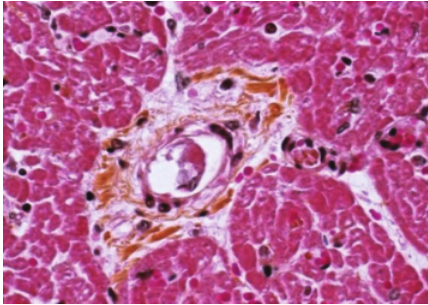
Figure 2: (High magnification) fibrinoid necrosis of vessel walls with perivascular myxoid